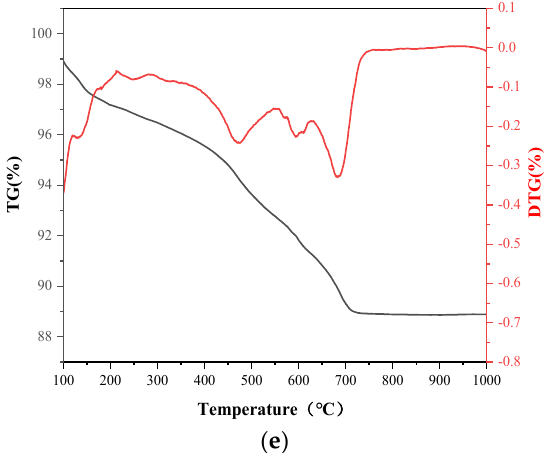
Figure 5. Thermal decomposition of sample under different recycled fine aggregate contents: ( a ) 10% recycled fine aggregate; ( b ) 20% recycled fine aggregate; ( c ) 30% recycled fine aggregate; ( d ) 40% recycled fine aggregate; ( e ) 50% recycled fine aggregate.